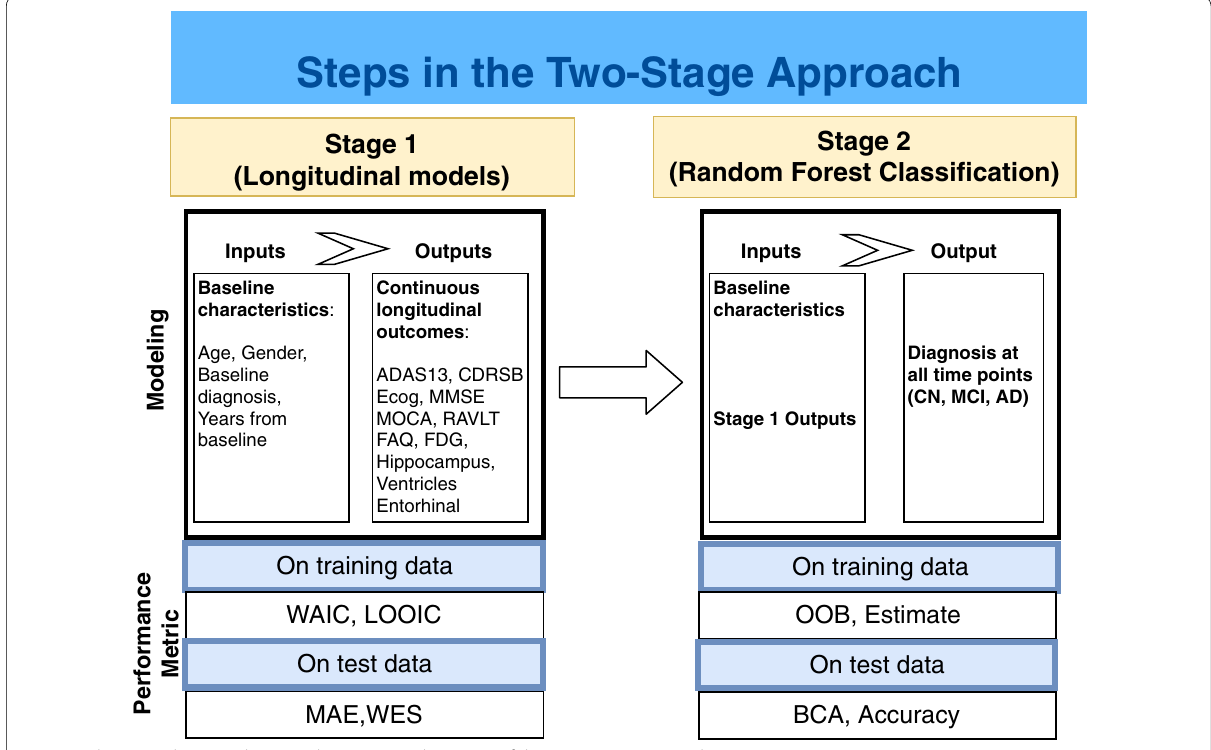
Fig. 1 Schematic diagram showing the inputs and outputs of the two-stage approach